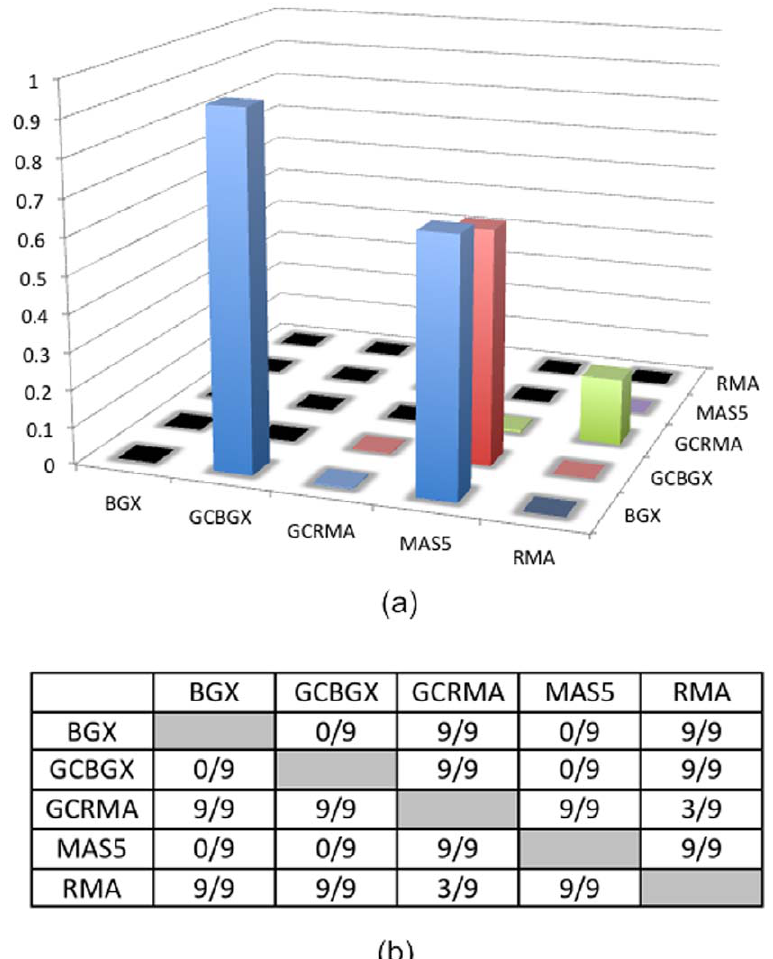
Figure 6. Testing the difference in VUS between different methods. (a) Average p-values over the nine comparisons. (b) Fractions of the nine comparisons being significant (p-value , 0.05). Please note that the nine comparisons in Turro et al [10] are not independent.